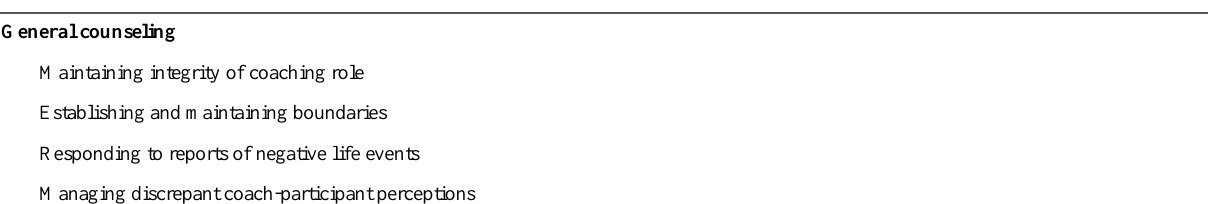
Table 2. Supervision themes and subthemes. Themes and